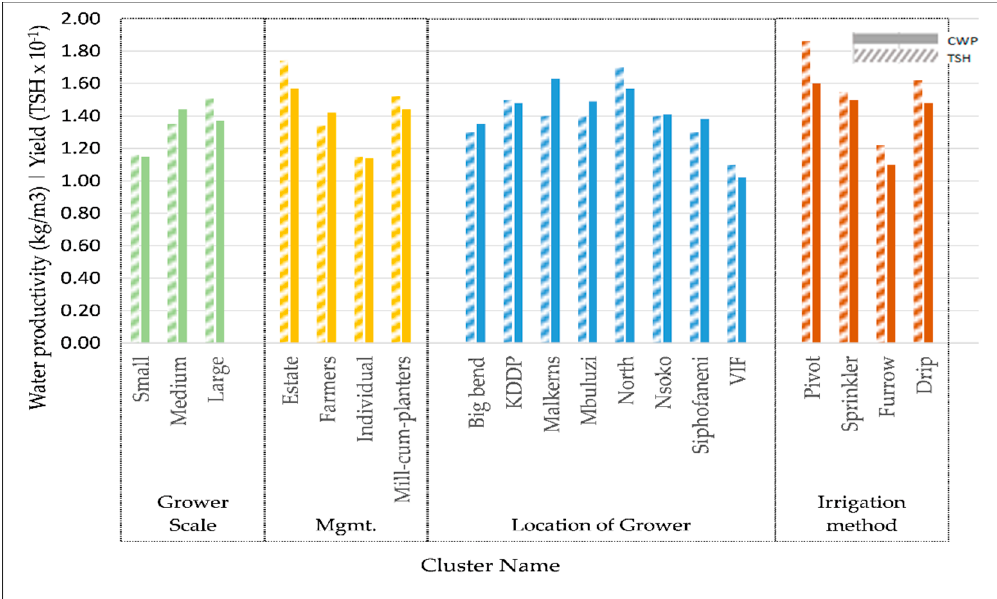
Figure 9. Mean crop water productivity calculated using beneficial biomass for the different cluster grower scale, management regime and location